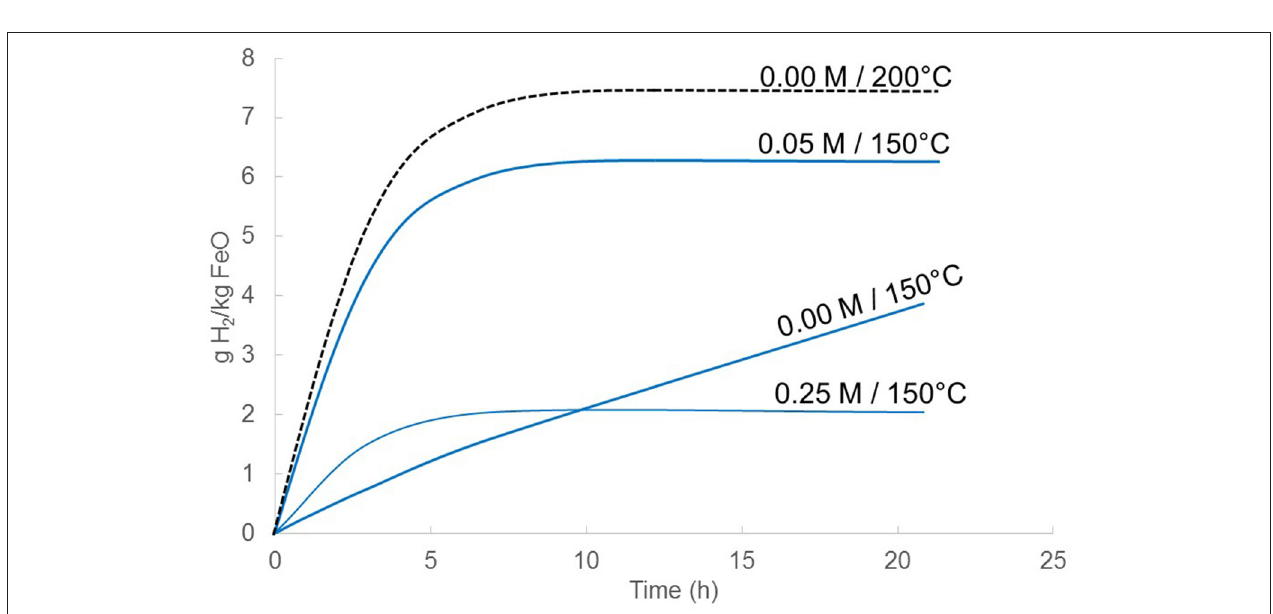
FIGURE 3 | Evolution of the mineralogy of a BOF slag treated hydrothermally at 50 MPa and 573K for 216h. Black sticks : mineralogical composition of the starting material; Gray sticks : Hydrothermal run product. Data are from Malvoisin et al. (2013).